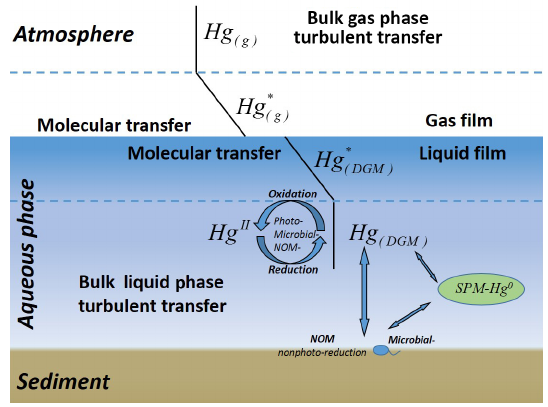
Figure 5. Conceptual view of DGM cycling in water and mass transfer process across the atmosphere-water